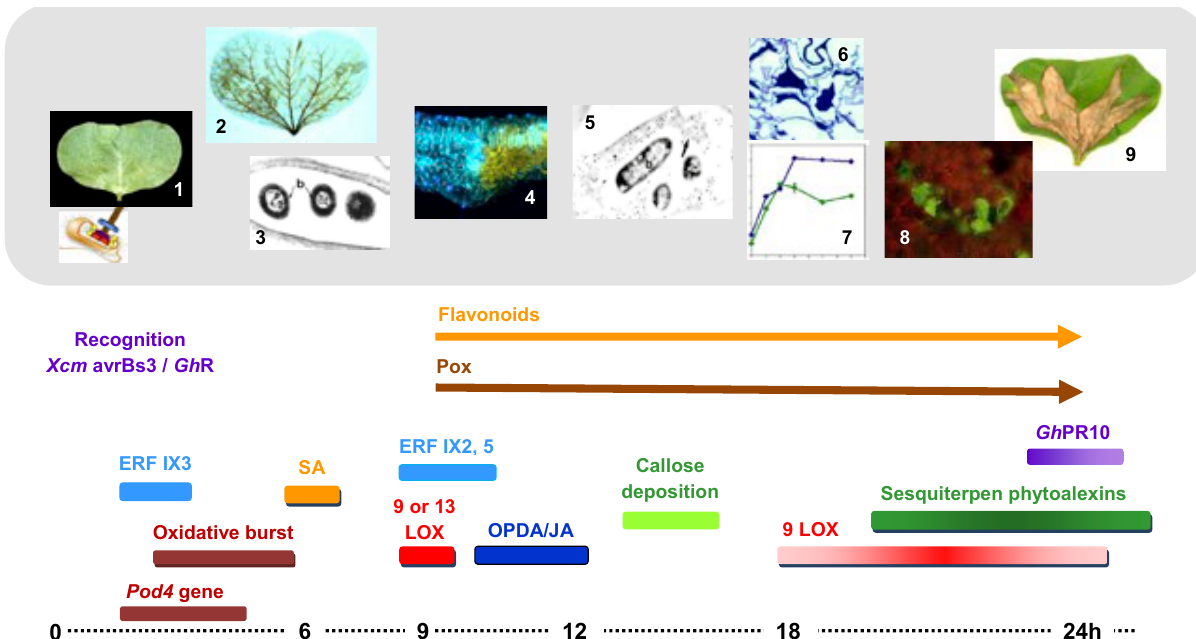
Figure 2. Time sequence of physiological events involved in the cotton HR to Xanthomonas citri pv. malvacearum . Following penetration of leaves by the pathogen (1 and 3), bacterial cells injected the effectors within the host nuclei. When recog - nized by host R proteins, several specific mechanisms were activated through signaling pathways. Genes of the ERF IX3 group are transcribed in parallel to the production of ROS (t = 3h; 2: localization of H 2 O 2 in resistant leaves). Accumulation of SA culminated after the burst (t = 6h) and before activation of a 9- or 13-Lox gene (t = 9h), transcription of ERF genes and synthesis of OPDA/JA (t = 12h). Production of flavonoids (orange stained in infected areas; 4) and total peroxidase activ - ity (5 : electron microscopic immunolocalization of peroxidase close to the bacteria) were also detected at the same time. Callose deposition contributed to stop the bacterial growth (7: green line) as compared to growth in susceptible plants (7: blue line), and preceded collapse of cells (6: condensation of the cytoplasm of HR cells). Appearance of HR symptoms in infected areas from t = 24h (9) occurred following dramatic increase in 9-Lox activity and strong accumulation of ses- quiterpene phytoalexins (8: green fluorescence). Photo credits. 1, 2 and 7, A. Jalloul; 3, 5 and 6, M. Nicole; 4, G. Dai; 8, M. Essenberg; 9, M.